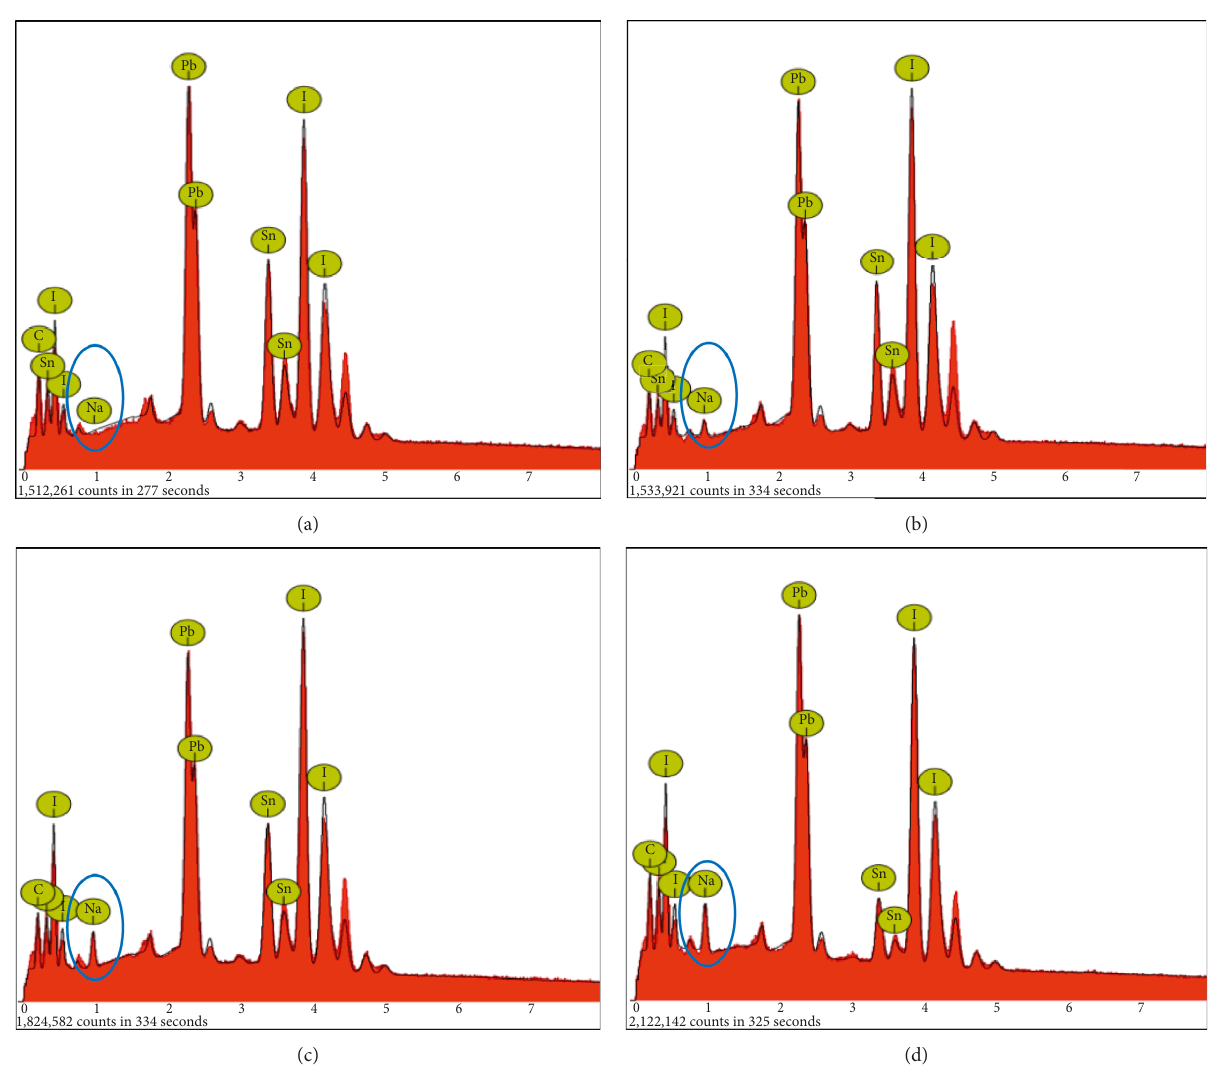
Figure 2: The energy dispersive X-ray spectroscopy (EDS) of films with Sample+0M (a), Sample+0.75M (b), Sample+0.9M (c), and Sample+1.2M (d) (the blue ellipse area is the peak position of Na + ).